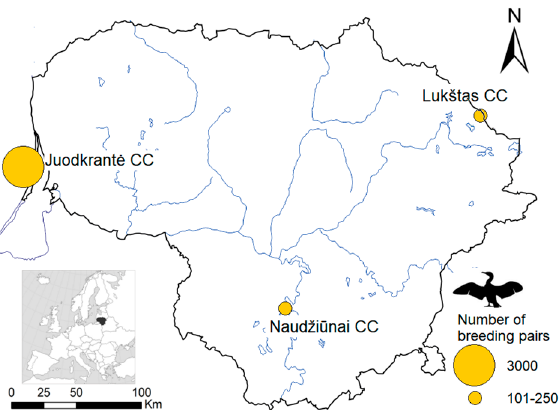
Figure 1. Investigation sites, referred as CC—cormorant colony, with main rivers and lakes shown in blue. Based on free map from https://d-maps.com/carte.php?num_car=2367&lang=en (accessed 4 January 2023); bird silhouette from